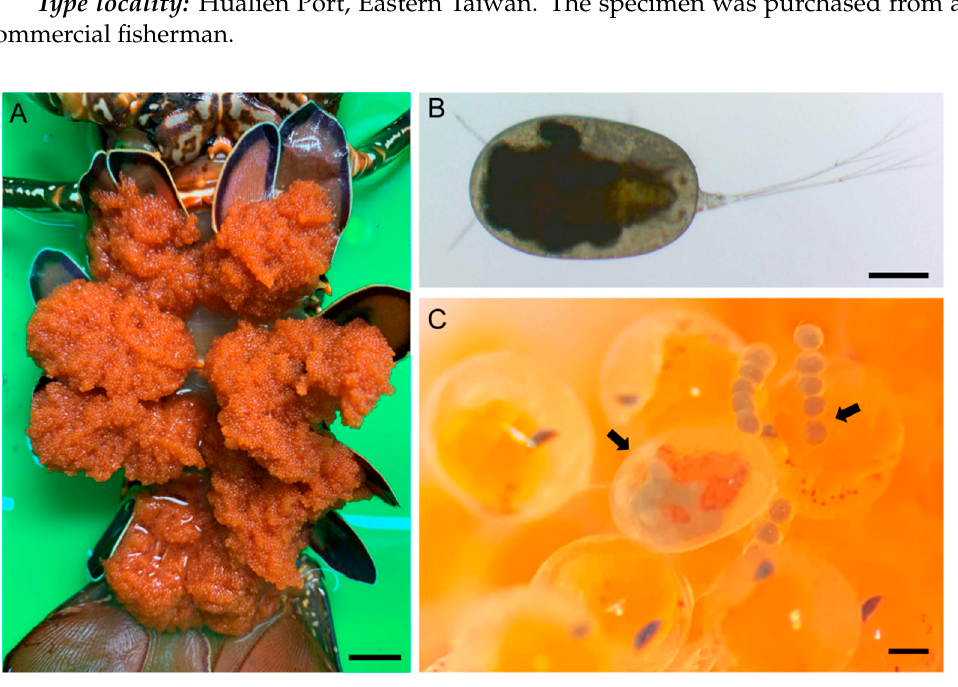
Figure 1. Living Choniomyzon taiwanensis n. sp. on the egg of host lobster Panulirus longipes longipes . ( A ) Ventral view (egg masses) of the P . l. longipes specimen, where the C. taiwanensis n. sp. specimens were collected; ( B ) female C. taiwanensis ; ( C ) ovigerous female of C. taiwanensis (left arrow) carrying egg sac (right arrow) attached on the egg of P. l. longipes . Scale-bars: A, 2 cm; B and C, 200 µm.